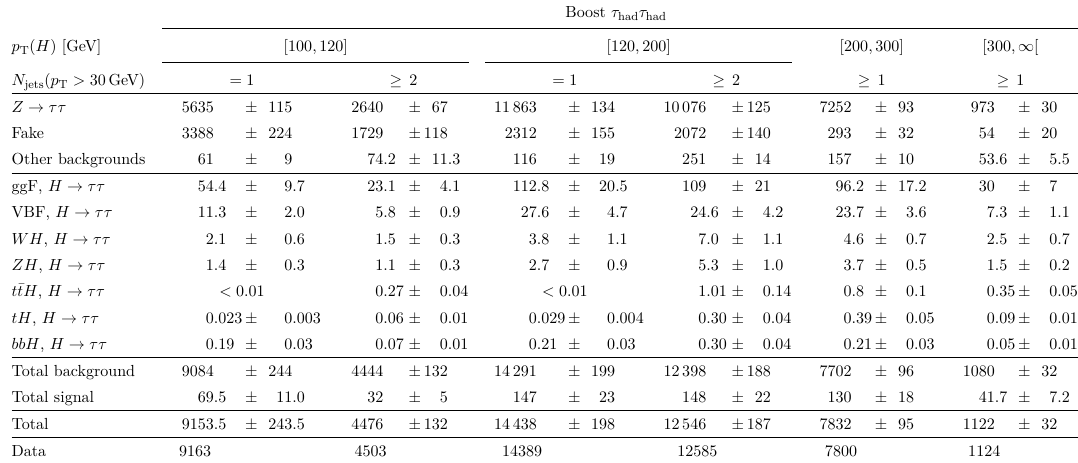
Table 11. Observed event yields and predictions as computed by the fit in the boost signal regions of the τ τ channel. Uncertainties include statistical and systematic components. The prediction had had for each sample is determined from the likelihood fit performed to measure the pp → H → ττ